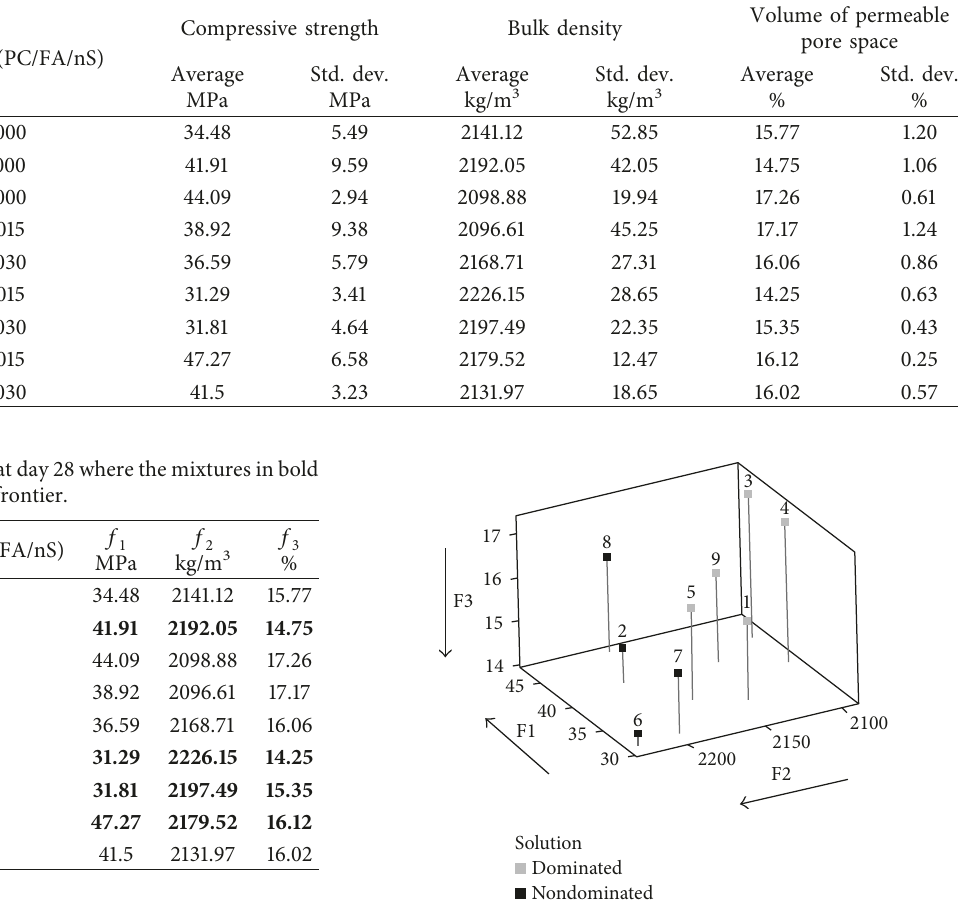
Table 10: Average result of performance measures at day 28.